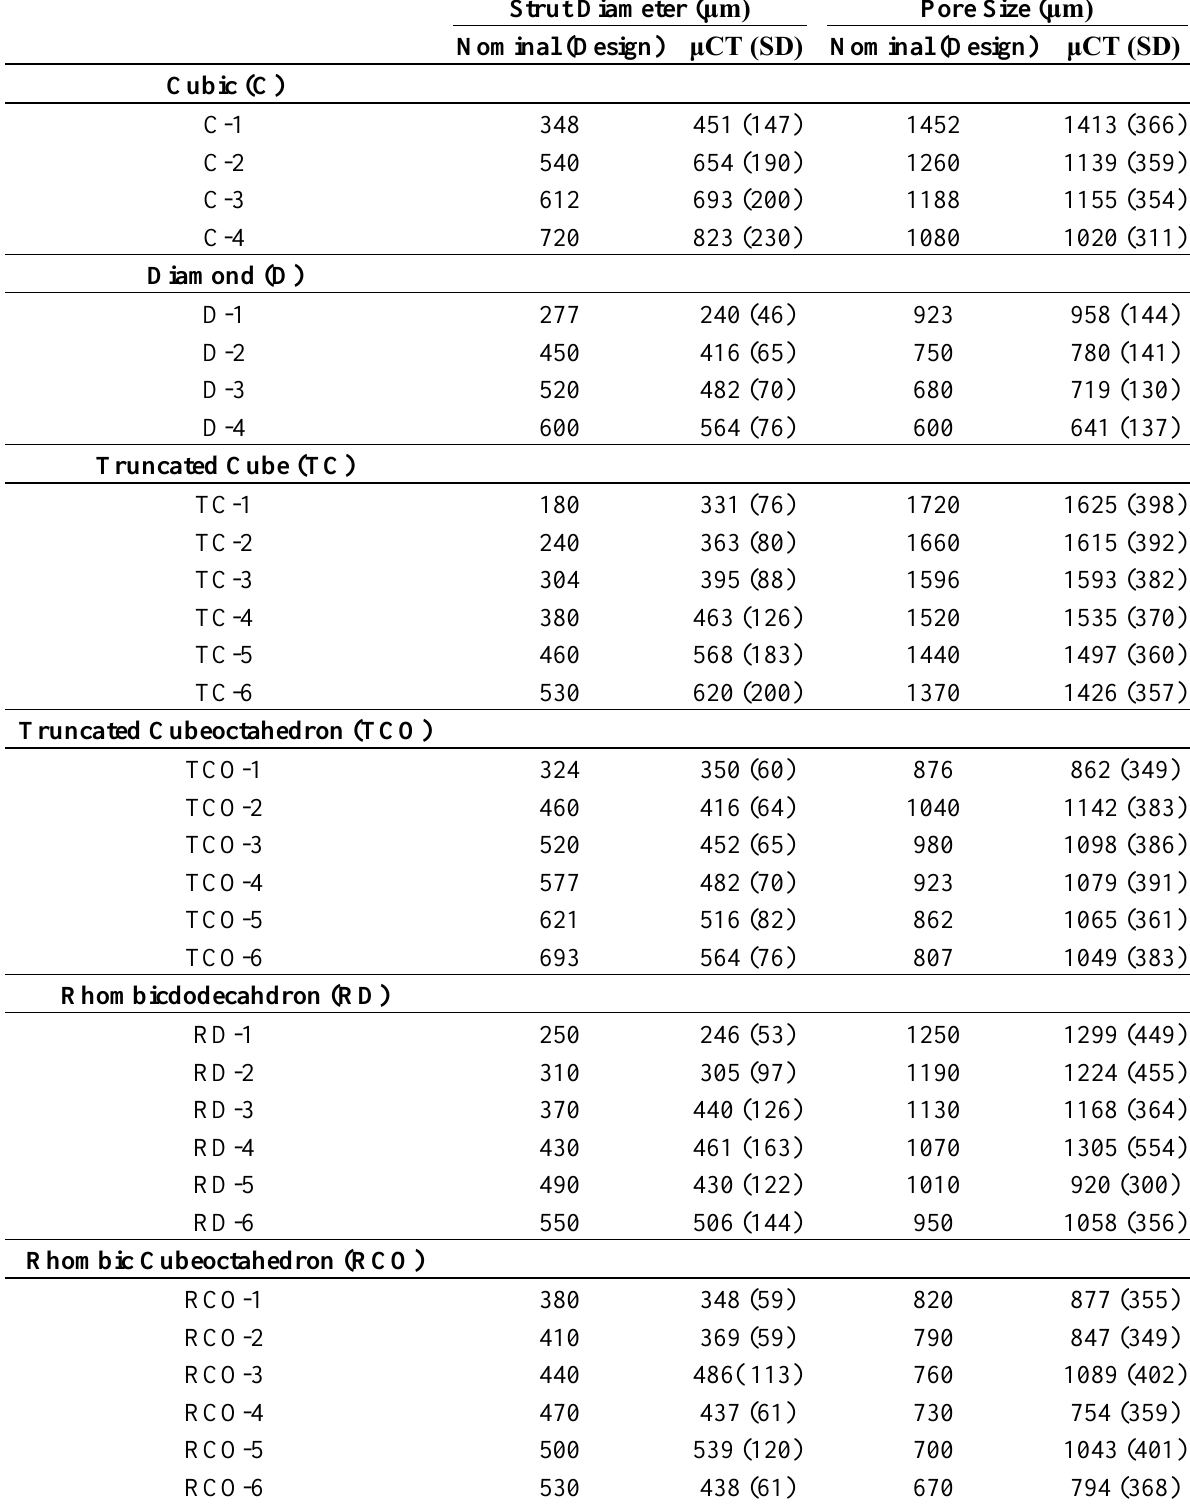
Table 1. Morphological properties of the porous structures